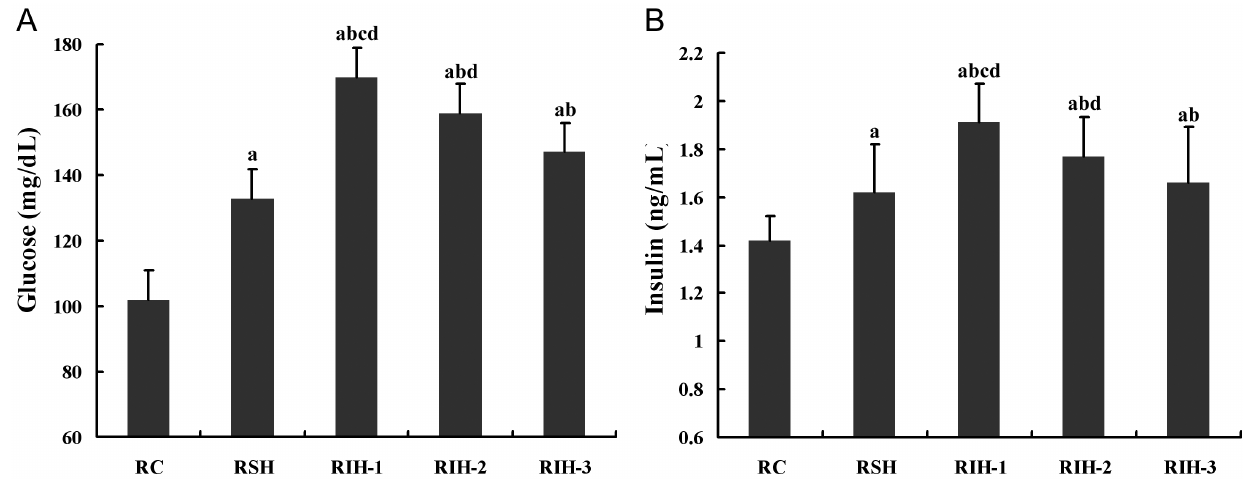
Figure 1. Insulin and blood glucose levels in rats . a P , 0.05 compared with RC group; b P , 0.05 compared with RSH; c P , 0.05 compared with RIH- 2,. d P , 0.05 compared with RIH-3.